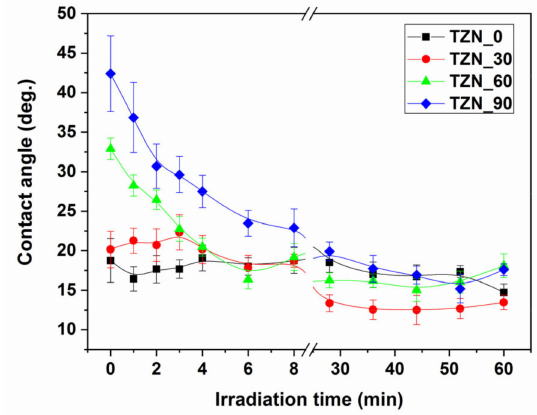
Figure 8. Contact angle vs. irradiation time during surface